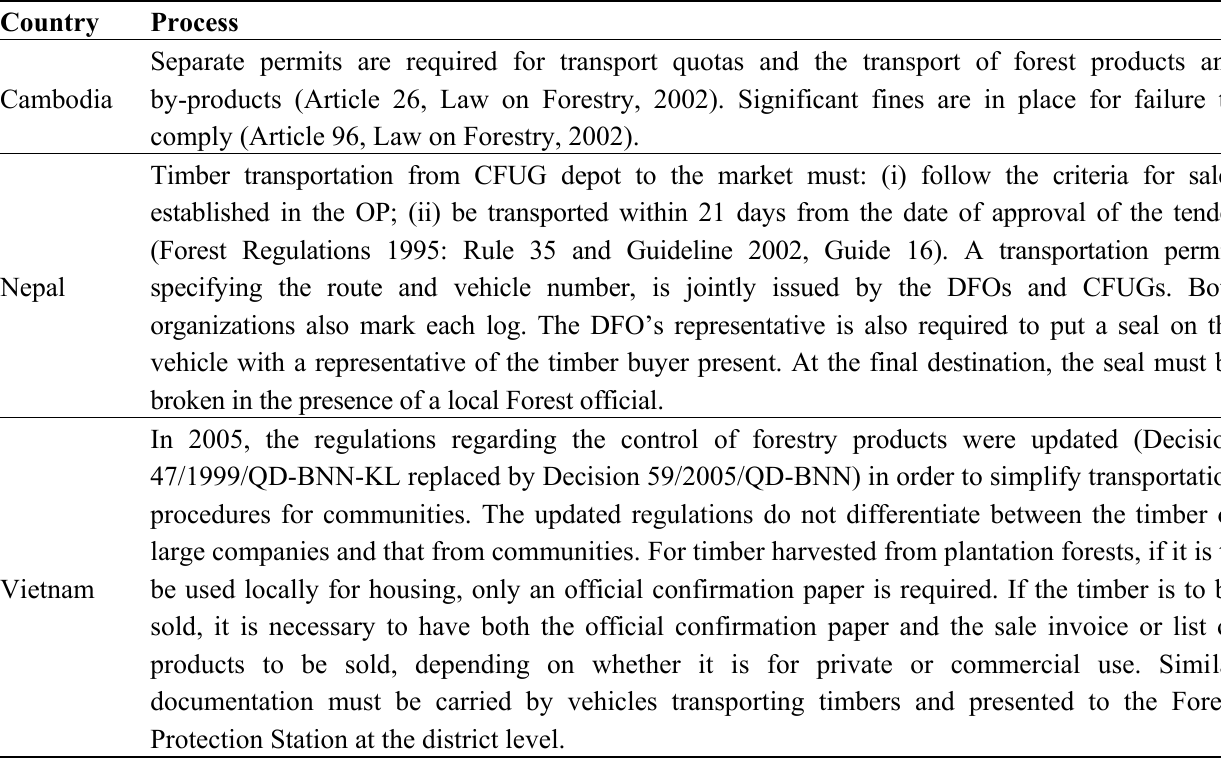
Table 5. Details of requirements for transporting timber from community forests in each country